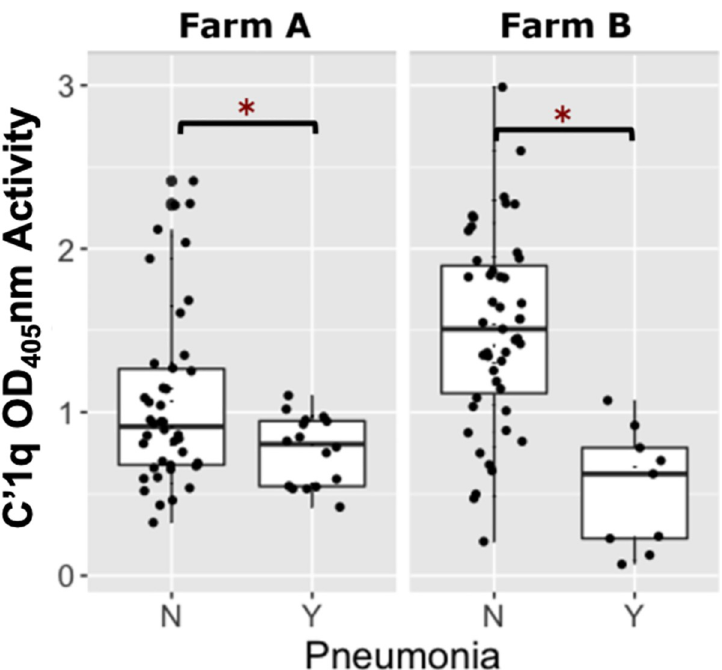
Fig 6. Foals transfused with PNAG hyperimmune plasma and the comparison of C ՛ 1q activity with whether they developed pneumonia or remained healthy. Boxplot of optical density (OD 405 nm) activities for complement component 1q (C ՛ 1q) deposition onto PNAG by serum antibodies in 116 foals transfused with PNAG hyperimmune plasma (PNAG HIP) stratified by pneumonia status, faceted by farm. Foals transfused with PNAG HIP at both farms that remained healthy (no pneumonia = ‘N’) had significantly higher (asterisks indicate P < 0.05) C ՛ 1q deposition activities than foals that developed pneumonia (pneumonia = ‘Y’).